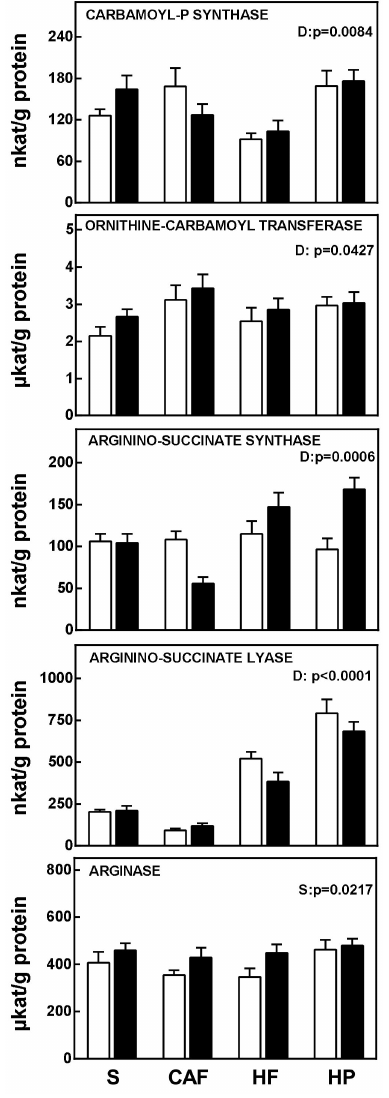
Figure 2. Enzyme activities related to the urea cycle in the liver of male and female rats fed a standard, cafeteria, high-fat, or high-protein diet for 30 days. The data correspond to the mean ± SEM of 6–8 different animals, and are all expressed per gram of tissue protein. Females are represented in white bars, and males in black. Abbreviations: S is standard diet, CAF is cafeteria diet, HF is high-fat diet, and HP is high-protein diet. Statistical analysis was done using a two-way ANOVA program for diet (D) and sex (S). Only significant values are